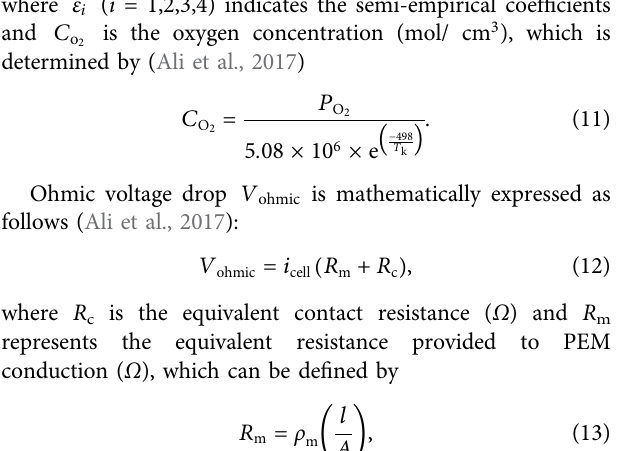
Frontiers in Energy Research |